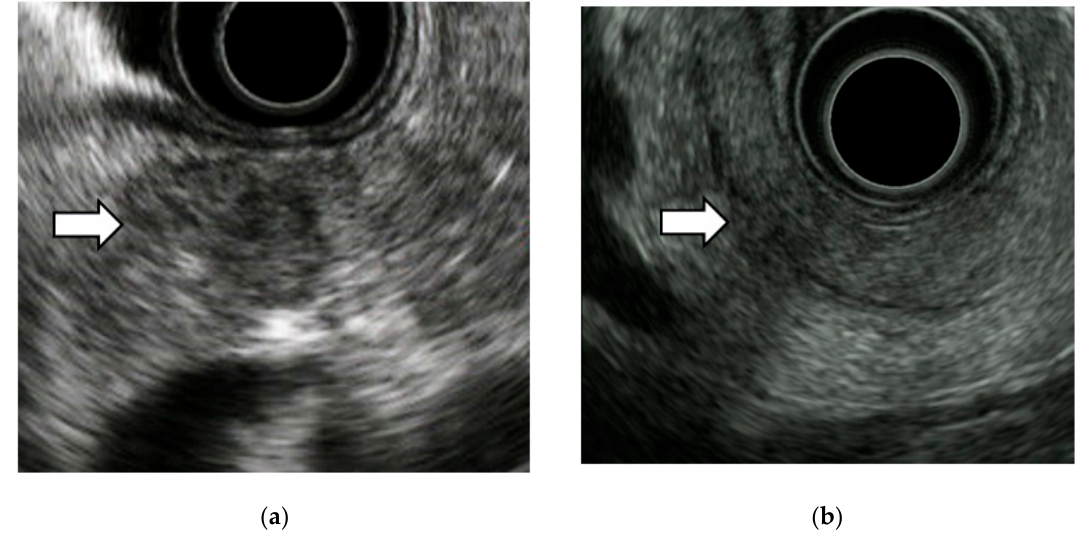
Figure 3. EUS imaging findings of stage 0 PC. Ten cases of stage 0 PC had hypoechoic lesions